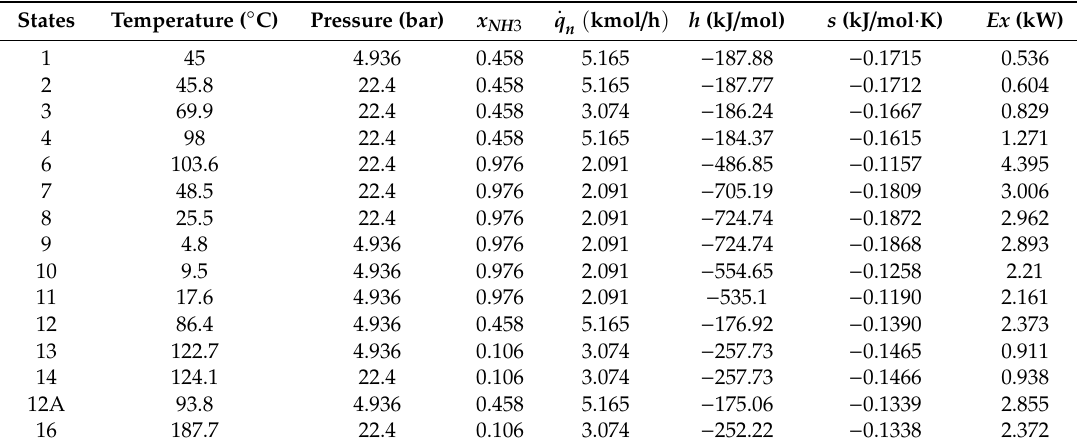
Table 3. Calculated state points corresponding to specific streams.